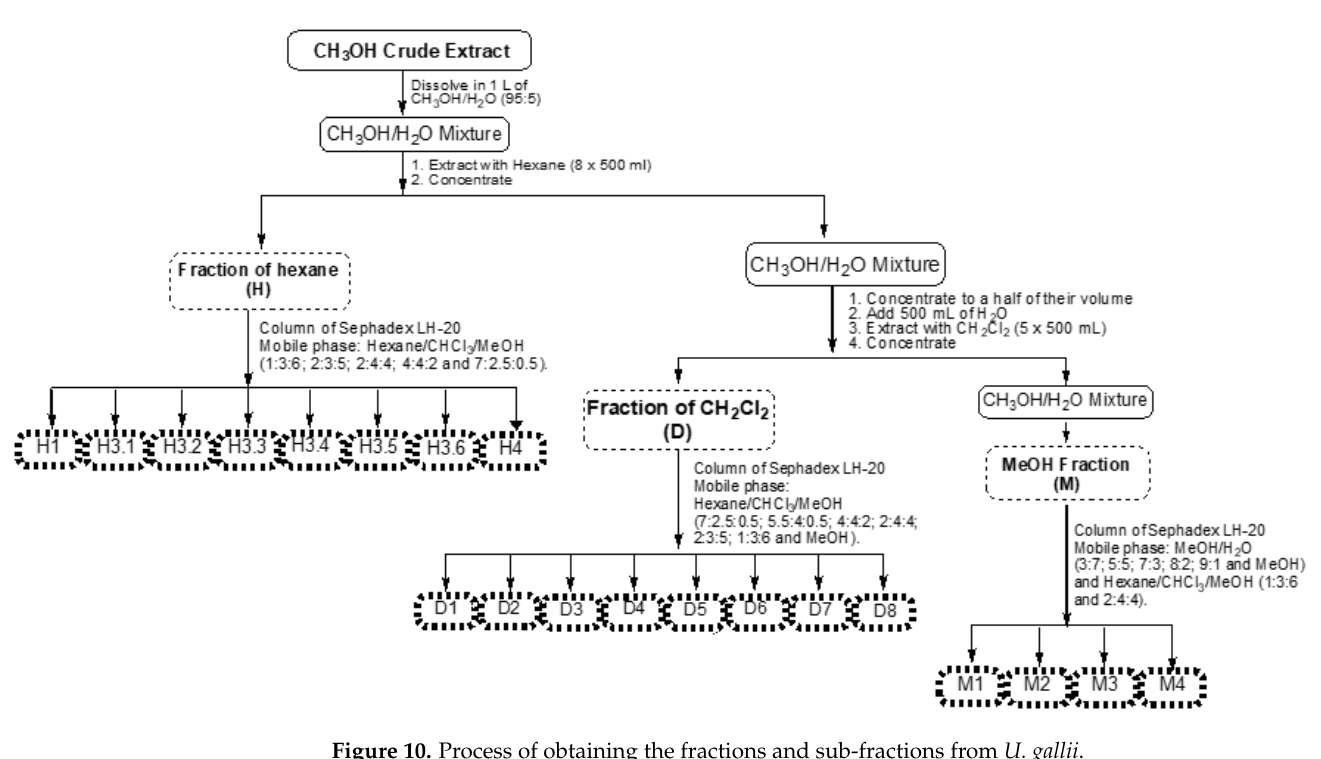
Figure 10. Process of obtaining the fractions and sub-fractions from U. gallii .